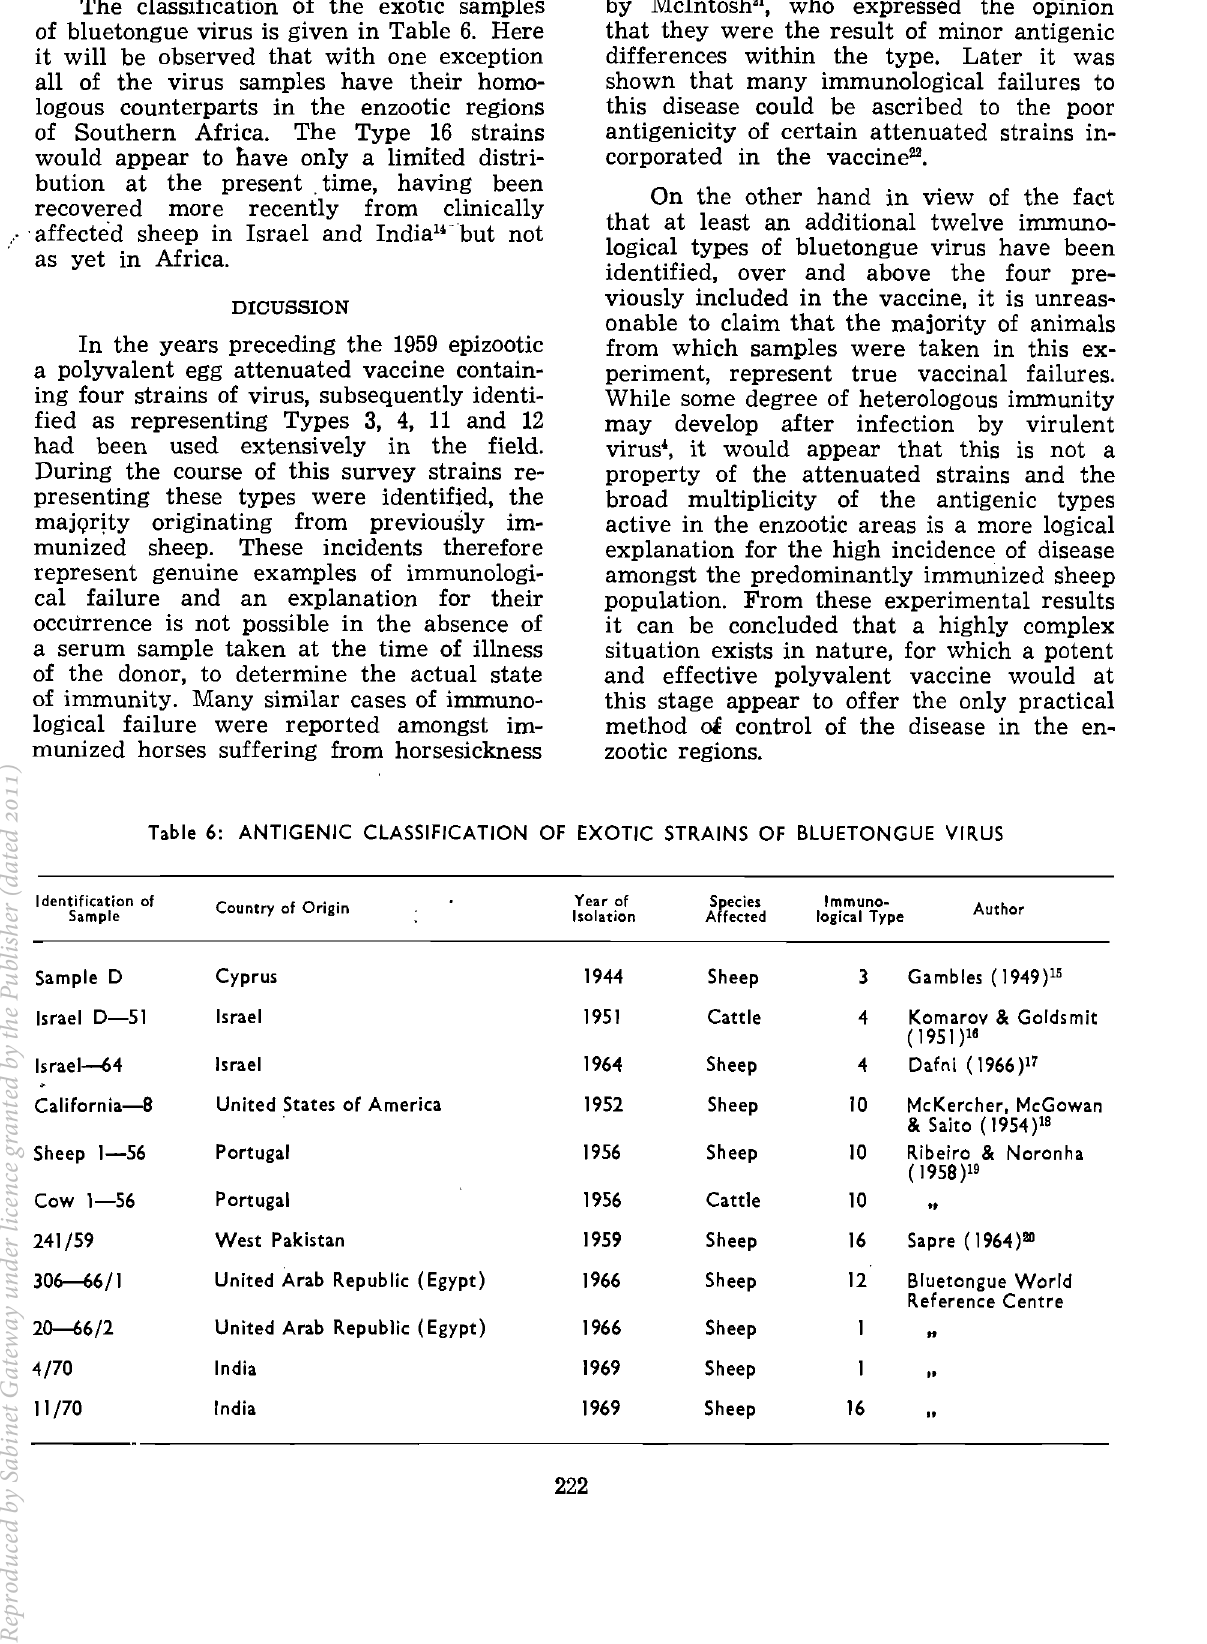
Table 6: ANTIGENIC CLASSIFICATION OF EXOTIC STRAINS OF BLUETONGUE VIRUS I dentification